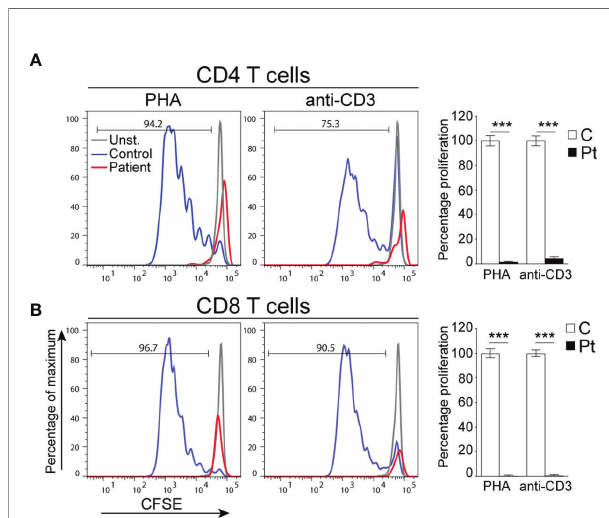
FIGURE 1 | Defective T cell proliferation in PBMCs from the patient. (A, B) Representative histograms depicting the proliferation of CD4 + (A) and CD8 + (B) T cells. Columns and bars represent the mean ± SEM of the percentage T cell proliferation with the controls set at 100%. N = 4 controls and the patient done in 2 experiments. ***p <